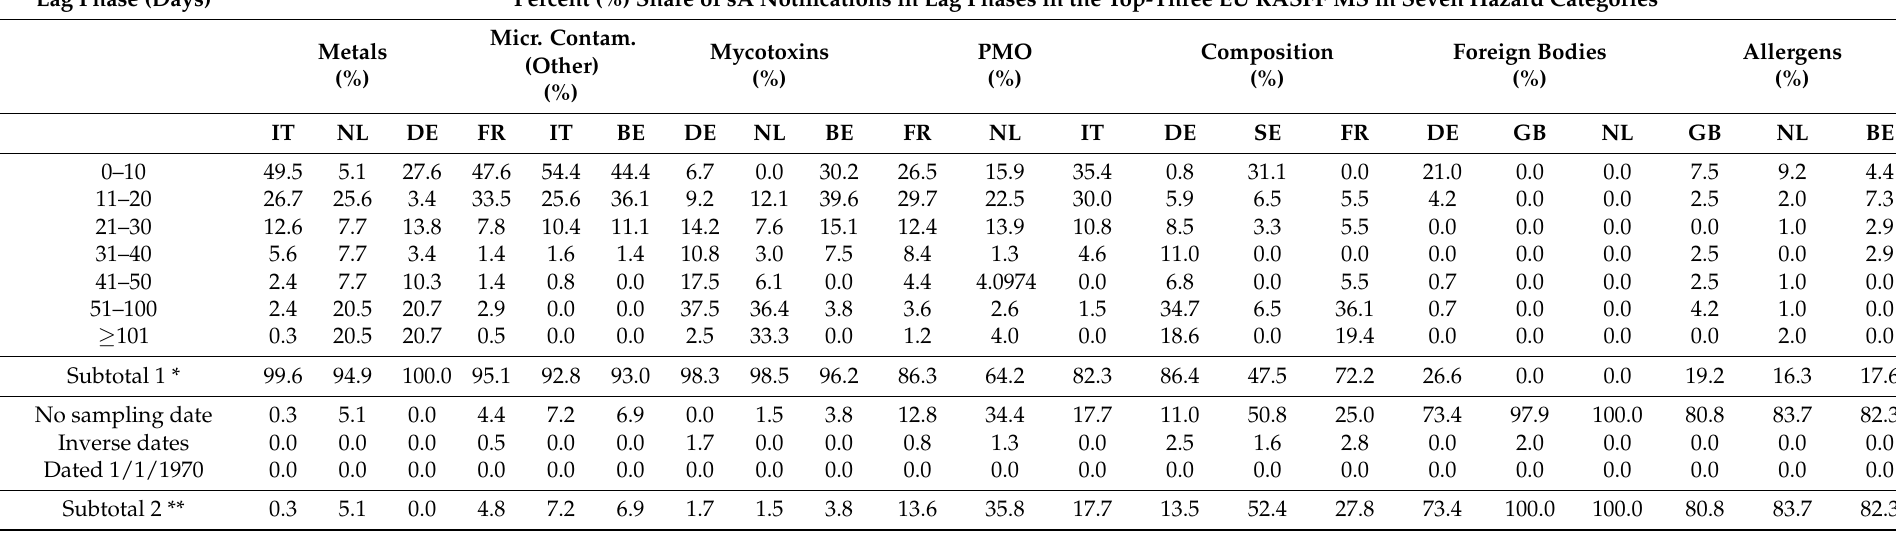
Table 4. Percent (%) share of lag phases in serious alert (sA) notifications in the top-three EU RASFF MS in each of the seven hazard categories (mycotoxins, microbial contaminants (other), foreign bodies, composition, allergens, metals, pathogenic microorganisms (PMO)), according to the EU RASFF database